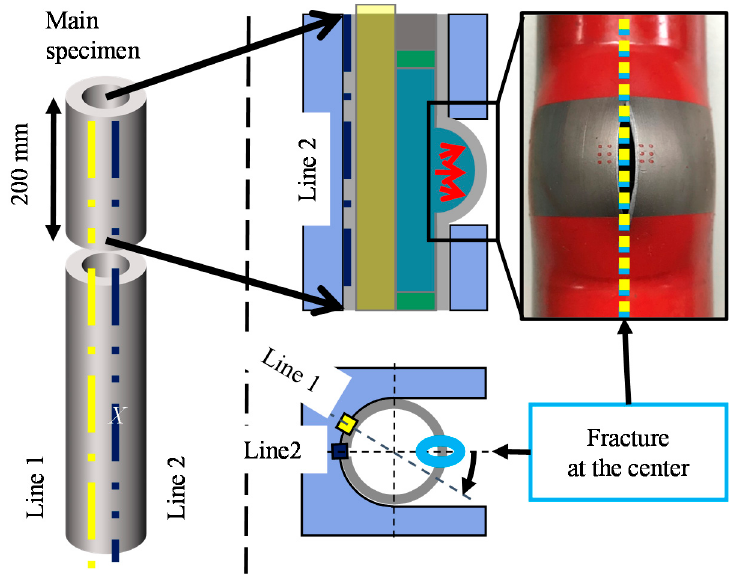
Figure 6. Overview of the main test.